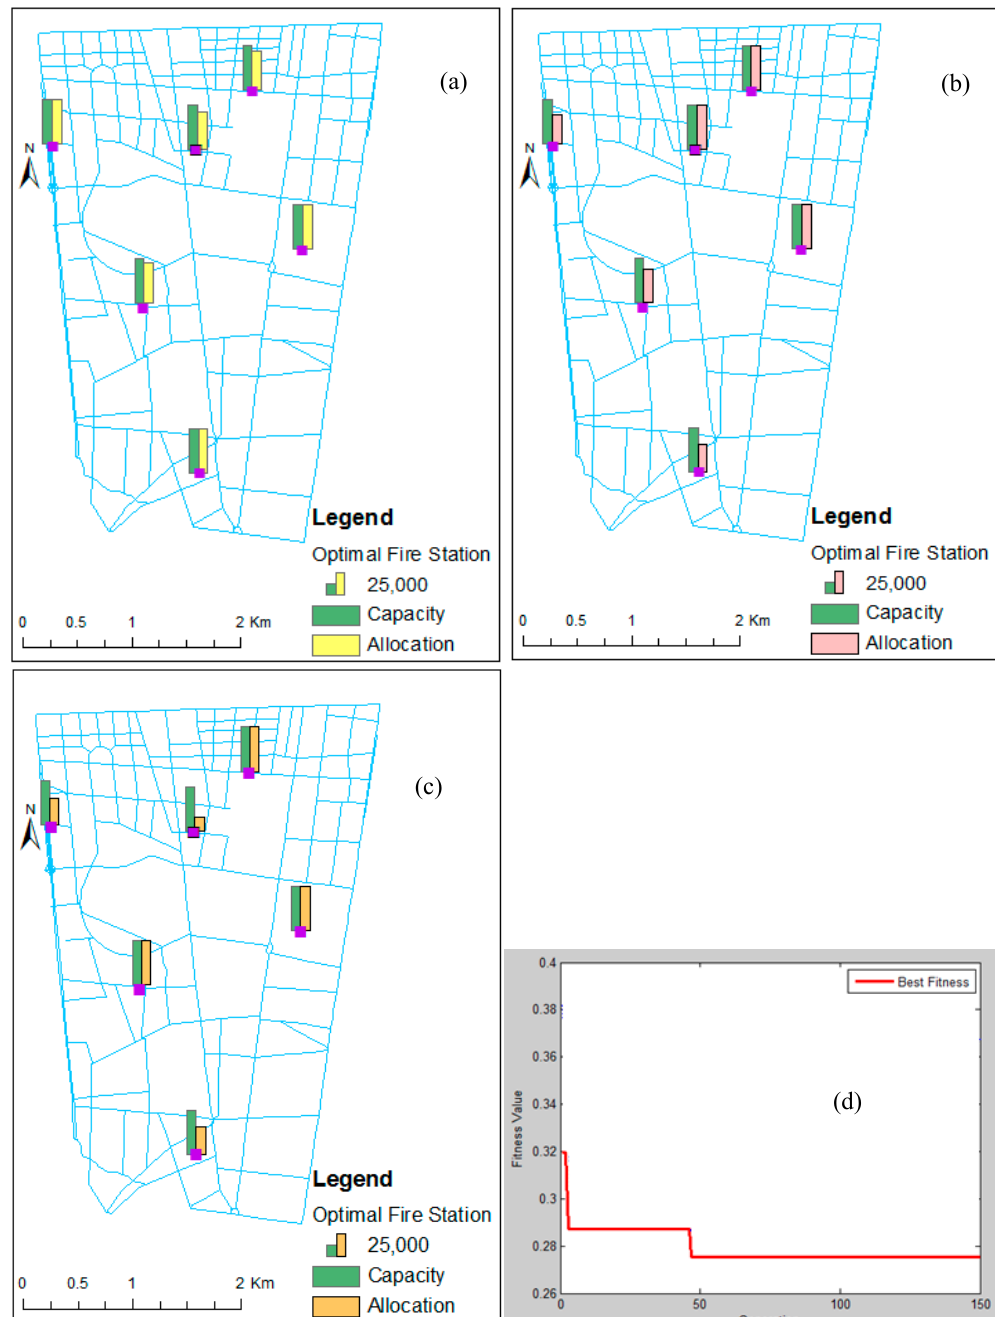
Figure 5. Optimal location of fire stations, their capacity, and allocations in ArcGIS by means of the best SA parameters with fixed weights ( W 1 = W 2 = W 3 = 0.3333 ) for functions ( a ) f1, ( b ) f2, ( c ) f3 and ( d ) fitness output graph. Table 4. Table of results.